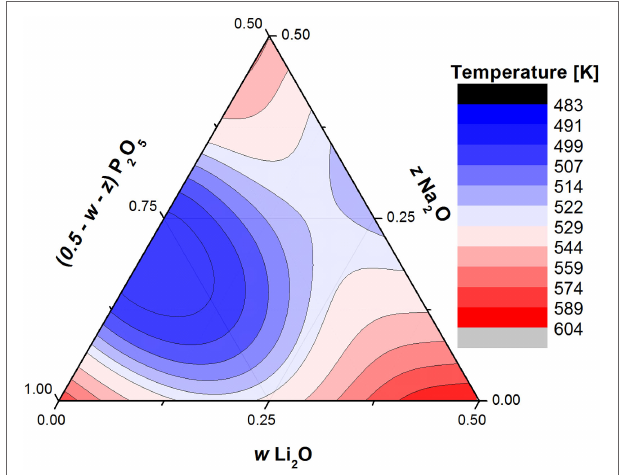
FIGURE 3 | Ternary diagram showing the calculated glass transition temperatures glasses within the w Li 2 O (cid:2) z Na 2 O (cid:2) (1 (cid:0) w (cid:0) z )P 2 O 5 with 0 (cid:20) ( w + z ) (cid:20) 0.5 using the proper values of constraint strength and γγγ .